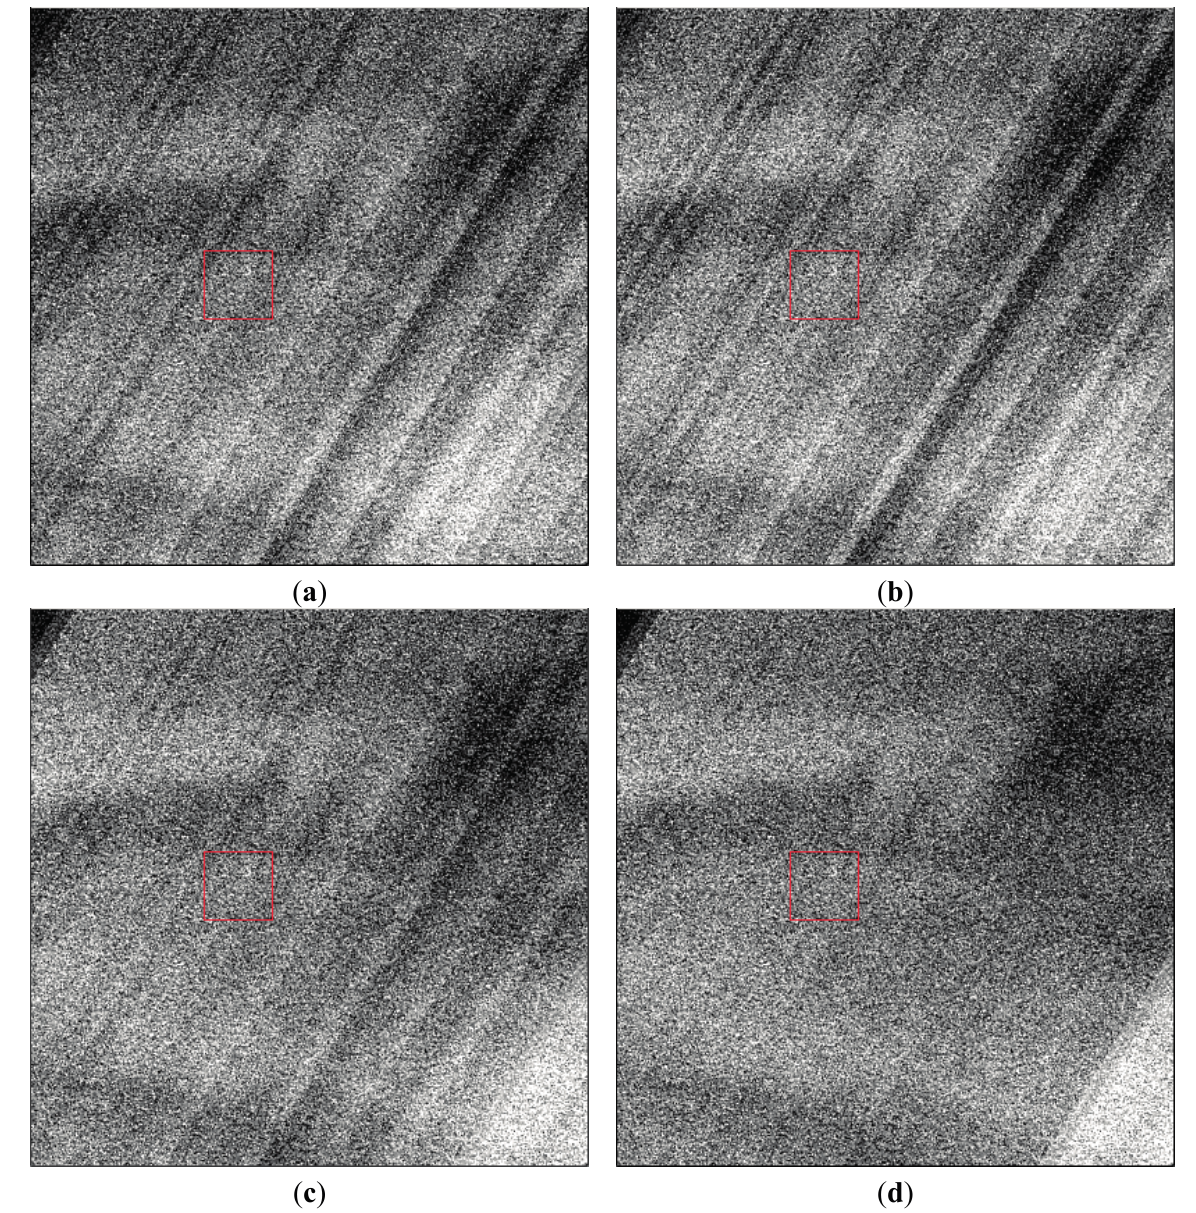
Figure 5. Hard-stretched test image (WRS-2 11/7, 16 June 2013) of the coastal/aerosol band, zoomed in around FPM 8 with the following sets of relative gains applied: ( a ) diffuser-based; ( b ) first side-slither (3/26/13, Niger (NER)); ( c ) fourth side-slither (4/24/2013, Greenland (GRL)); ( d ) sixth side-slither (5/12/13,